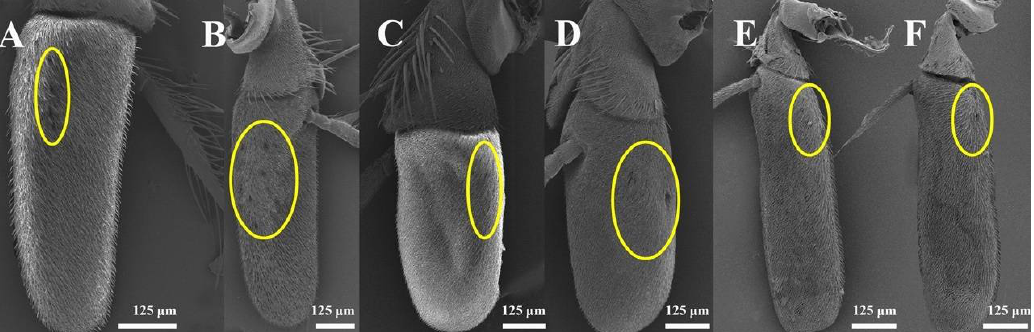
Figure 6. The sensory pits on the postpedicel of nine sarcophagid species. ( A ) S . albiceps , dorsal view; ( B ) S . albiceps , ventral view; ( C ) W . magnifica , dorsal view; ( D ) W . magnifica , ventral view; ( E ) M . campestris , ventral view; ( F ) M . campestris , dorsal view. Yellow circle marks area containing one or more sensory pits.